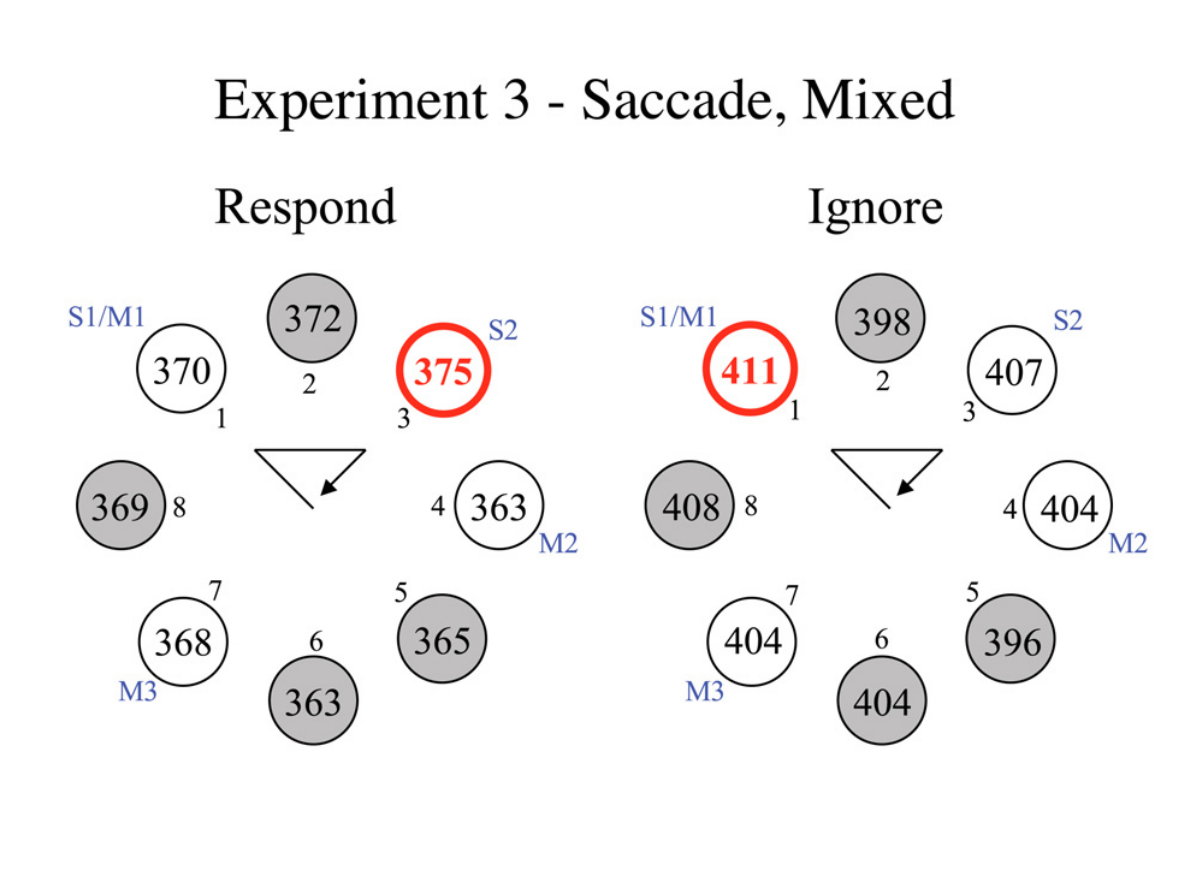
FIGURE 6. Mean of median saccadic RT in the Respond and Ignore conditions of Experiment 3. Again, formatting is the same as in Fig.